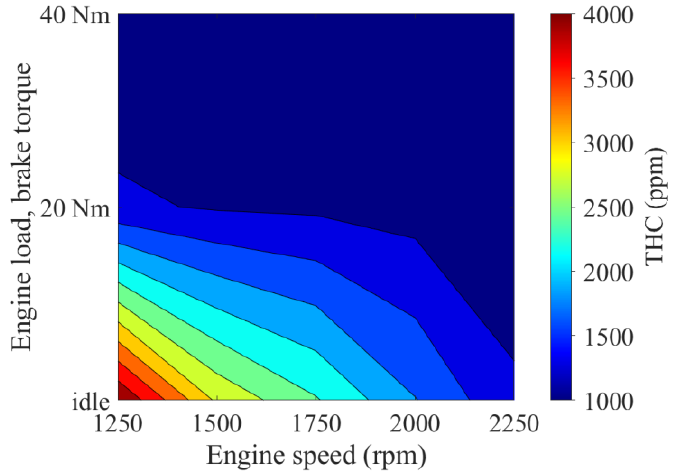
Figure 8. Total unburned hydrocarbons (THC) emissions by engine speed and